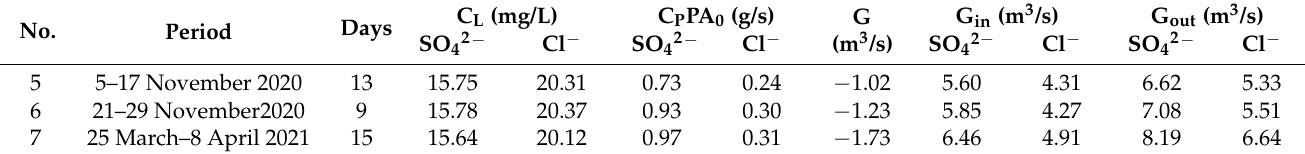
Table 3. Periods, day length and G of the three periods in Table 2, and given C L and C p PA 0 , and calculated G in and G out for the SO 42 − and Cl −